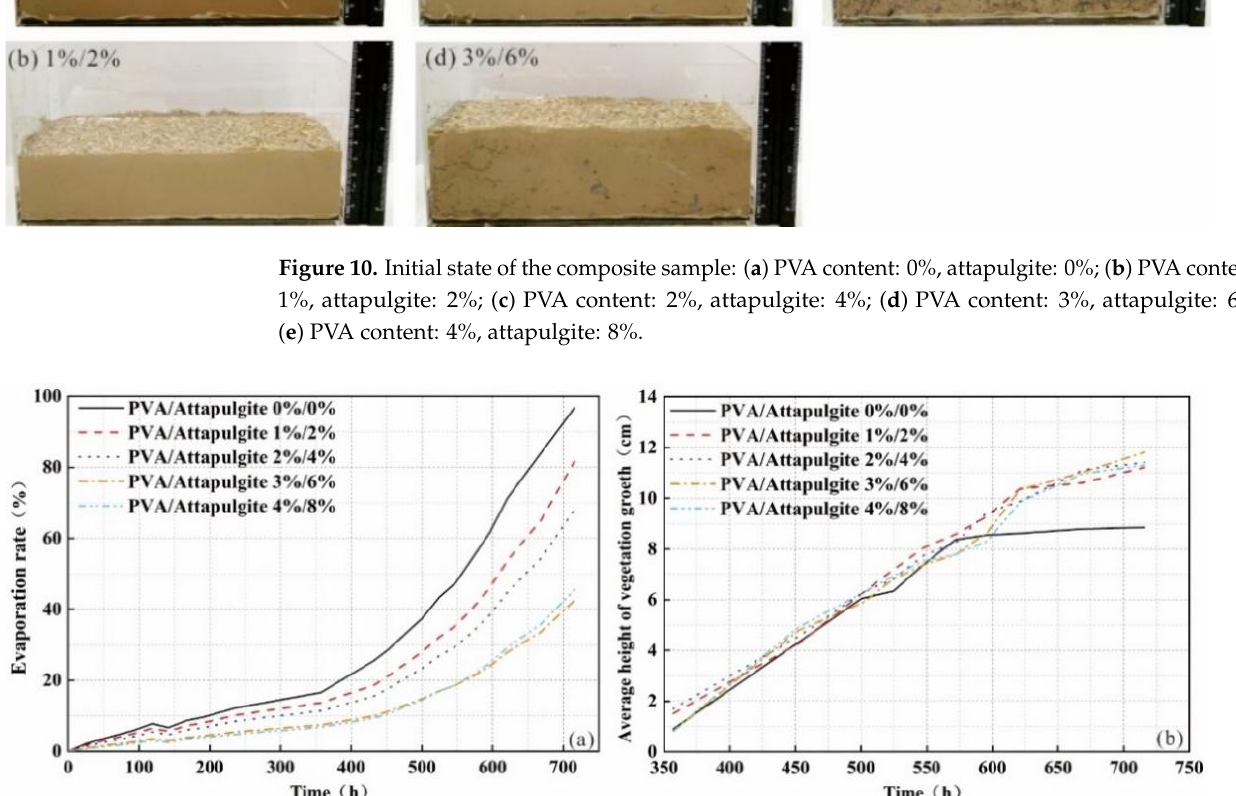
Figure 11. ( a ) The evaporation rate and ( b ) average height with different PVA content and atta- pulgite replacement.